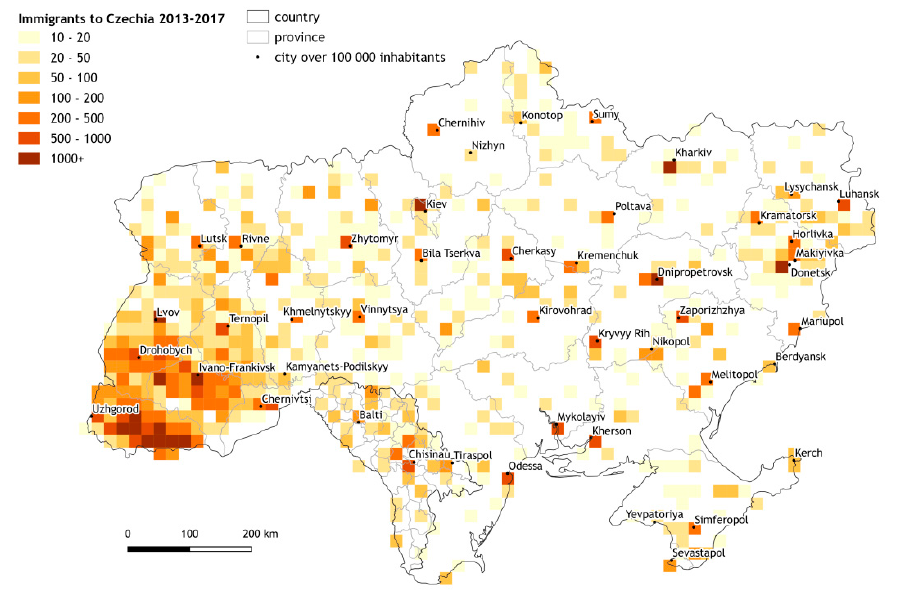
Figure 4. Spatial distribution of migrants into Czechia from Ukraine and Moldova between 2013 and 2017, including both permanent and temporary residence permits. Source: our own research.